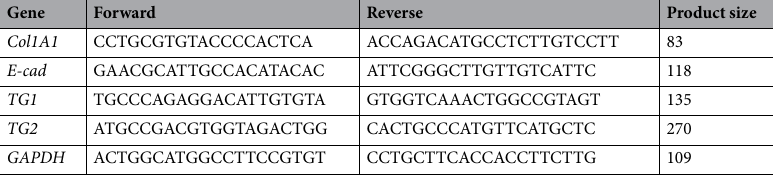
Table 4. Primer pairs for quantitative RT-PCR experiments using human tubular epithelial